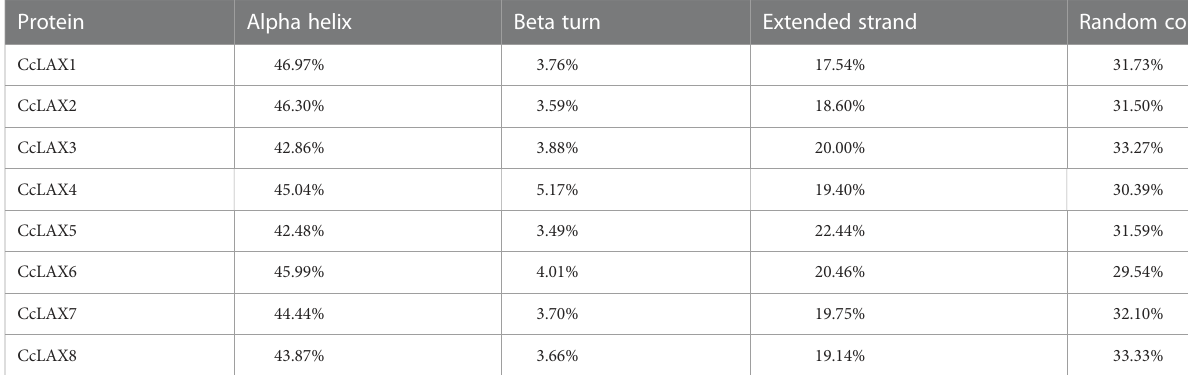
TABLE 2 Protein secondary structure of AUX/LAX protein in Chinese